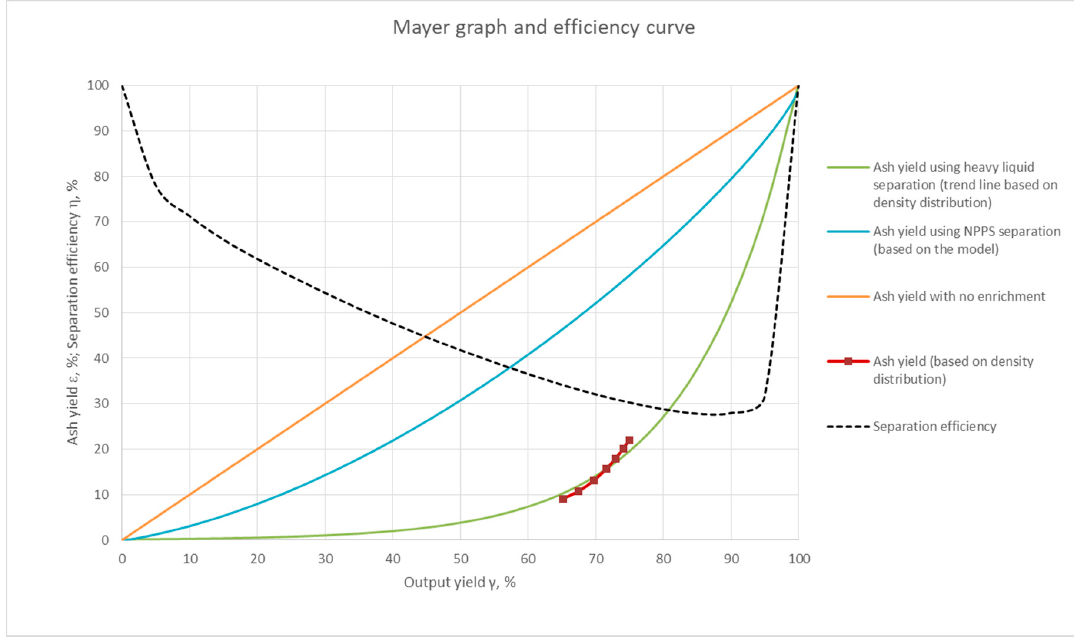
Figure 14. Assessment of the efficiency of coal separation with use of the NPPS in comparison to wet methods—feed material no. 1 in grain size class 0–20 mm.